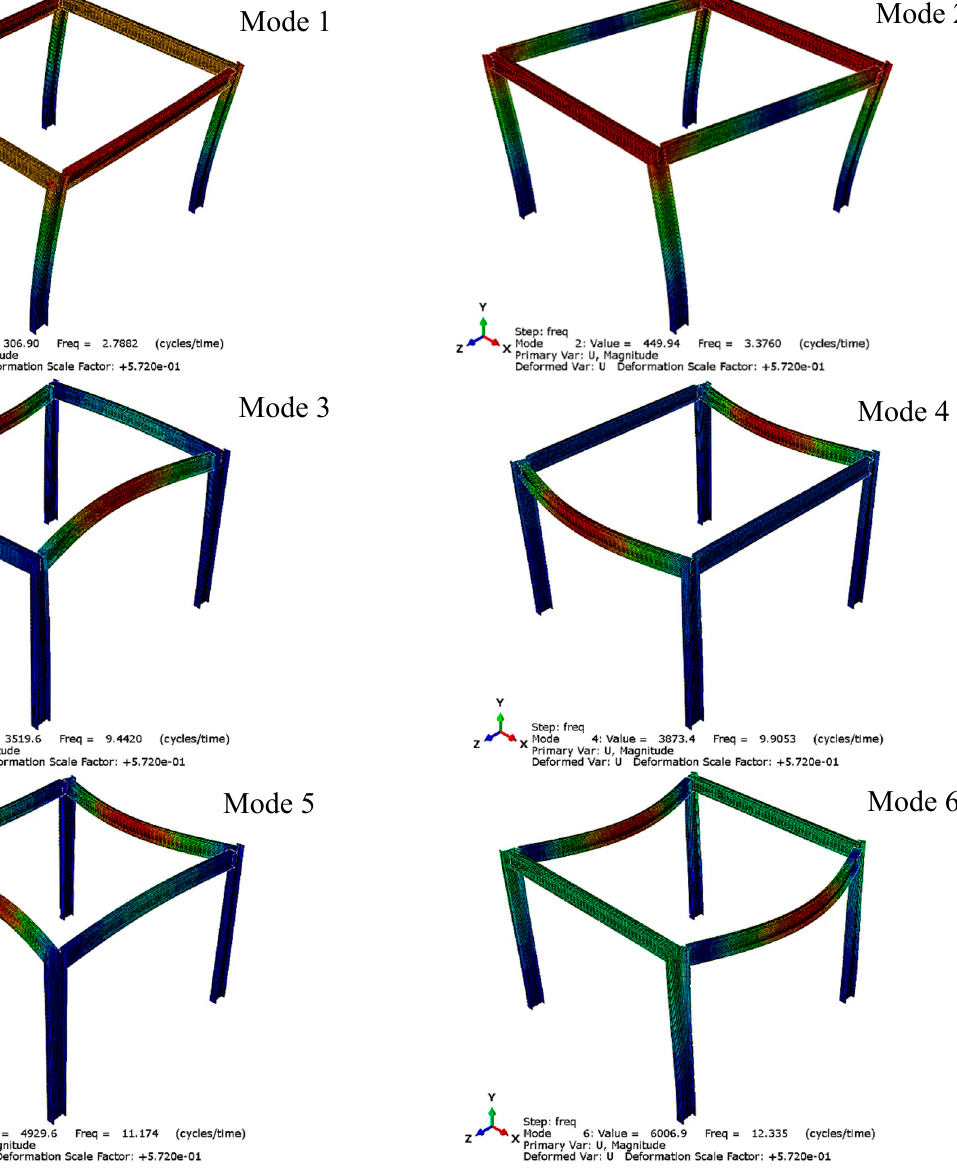
Figure 6. First six mode shapes for the steel framed structure following the frequency analysis.